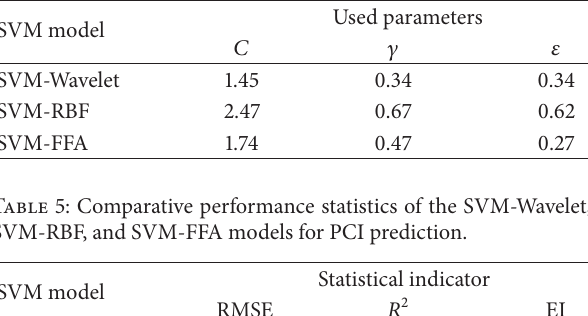
Table 4: User-defined parameters for SVM models.